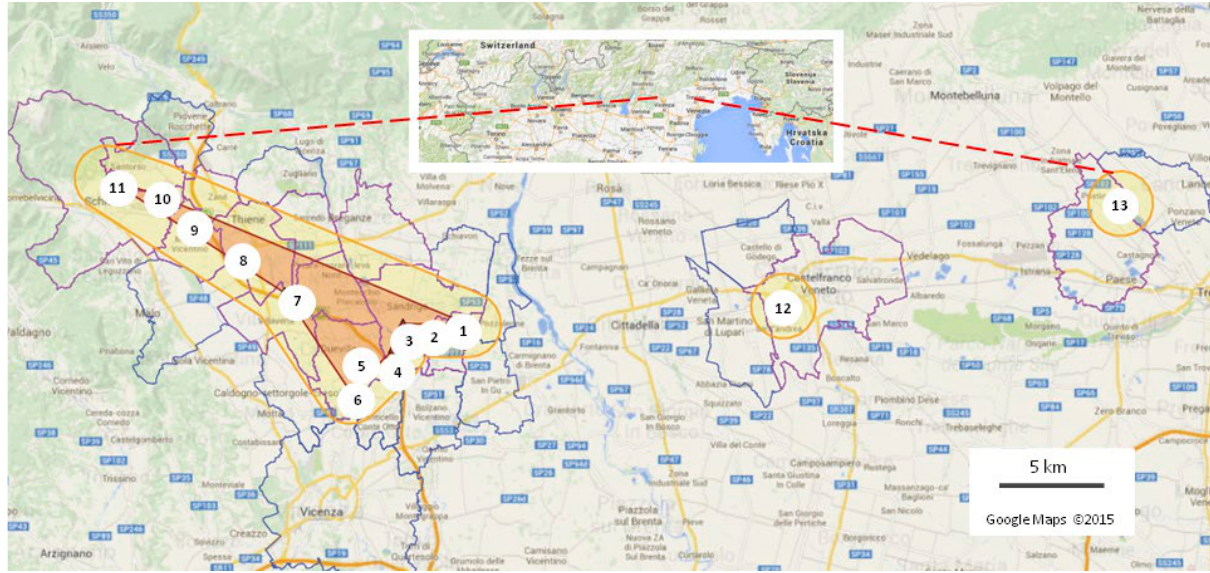
Figure 2. Official area of Italy affected by thousand cankers disease (pink) and buffer zone (yellow) as of August 2014 (Regione del Veneto, 2014). Sampling sites are numbered as reported in Table 1 (Cartographic basis: Google Maps